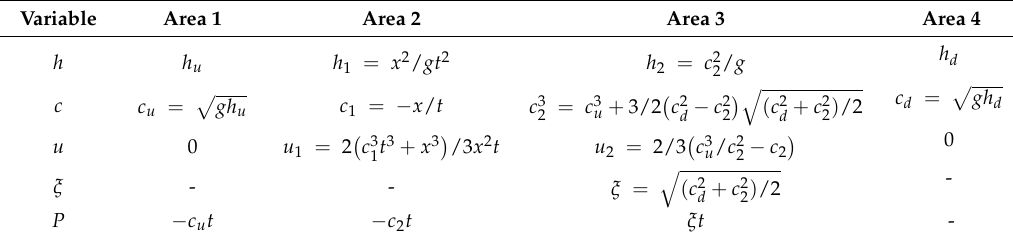
Table 2. Analytical formulas for 1D GWM in four areas.